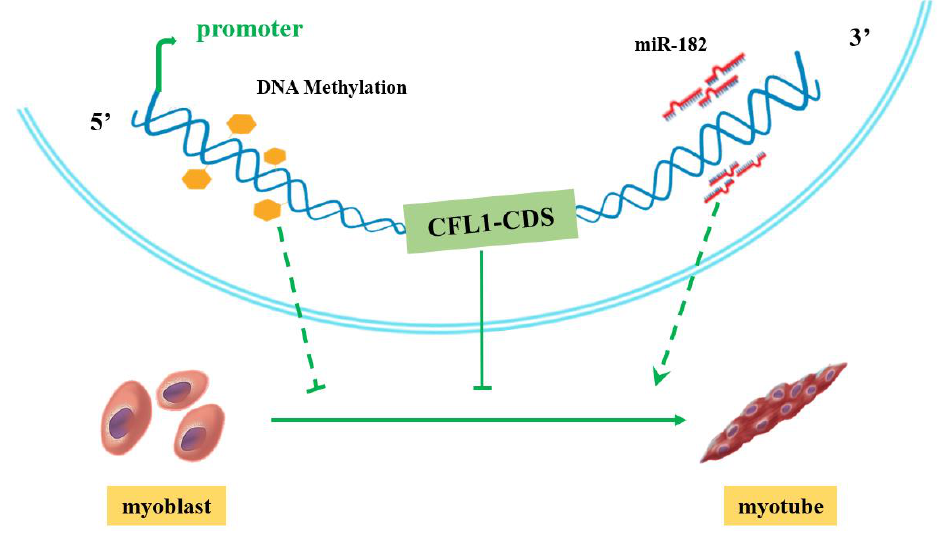
Figure 6. Proposed model of how the CFL1 gene regulates the differentiation of bovine primary